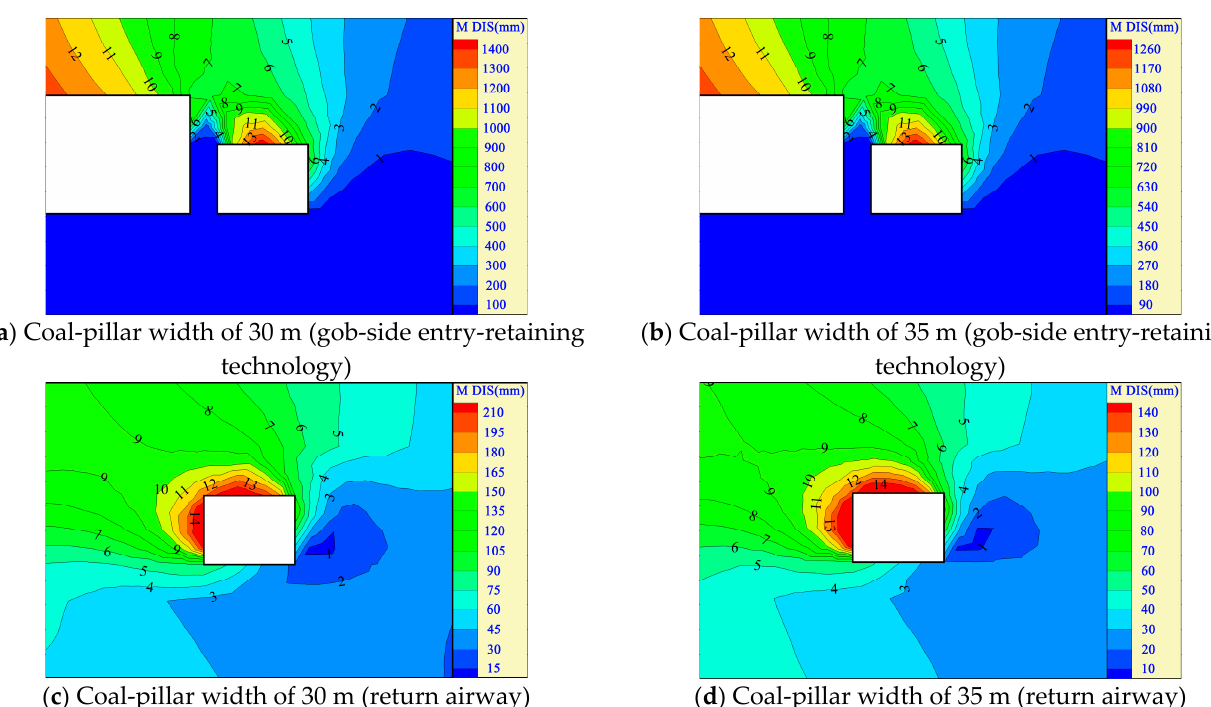
Figure 8. Plastic development of return airway at different reserved coal-pillar widths.